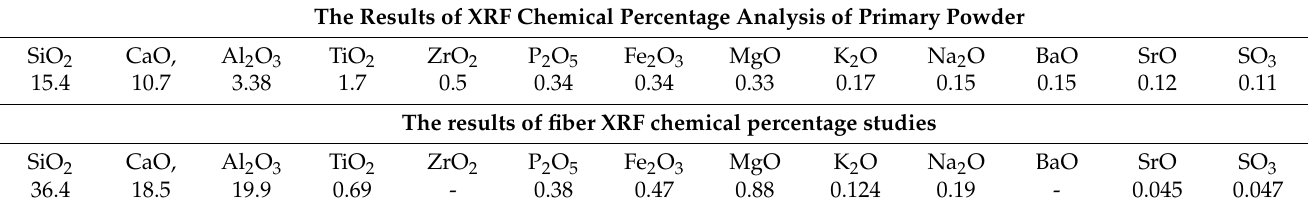
Table 2. The XRF study results of the primary powder and